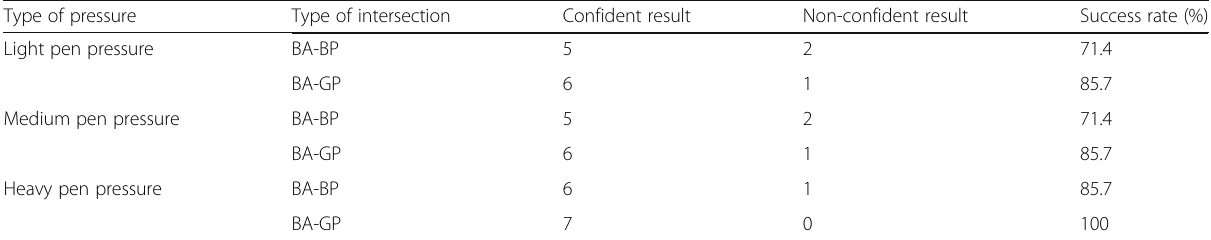
Table 2 Results of criterion 2 observed under Nikon A1 confocal microscope